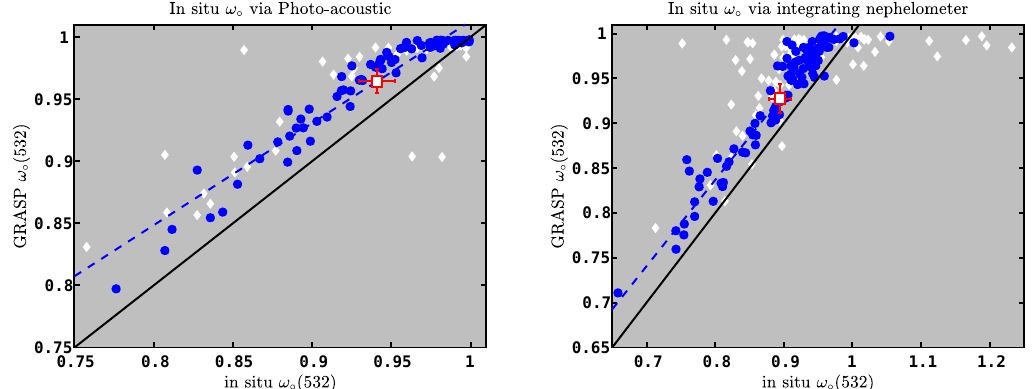
Figure 5. Comparison of single-scatter albedo derived using GRASP to ω ◦ derived directly from in situ measurements. GRASP retrievals use scattering angles identical to data with solar zenith angles of 50 ◦ in the AERONET database. Left panel uses photo-acoustic absorption coefficients to determine ω ◦ , whereas the right panel uses the integrating nephelometer. Blue circles indicate GRASP retrievals that have residuals of less than 8%, while white diamonds indicate the additional scatter that occurs when residuals are not restricted. Red square is the mean value, and error bars represent two standard deviations of the mean. Solid lines are 1:1 and dashed blue lines correspond to linear regression of the blue circles; statistics presented in Table